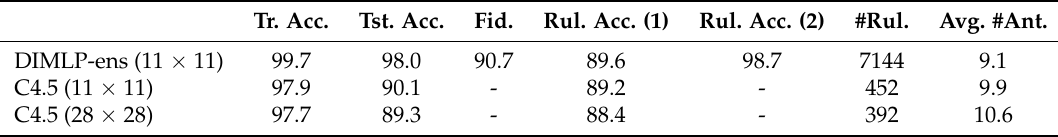
Table 4. Results obtained by a DIMLP ensemble and C4.5 decision trees (DTs). The first and the second row takes into account 11 × 11 images, while the third is related to 28 × 28 images. Tr. Acc. Tst. Acc. Fid. Rul. Acc. (1) Rul. Acc. (2) #Rul. Avg.